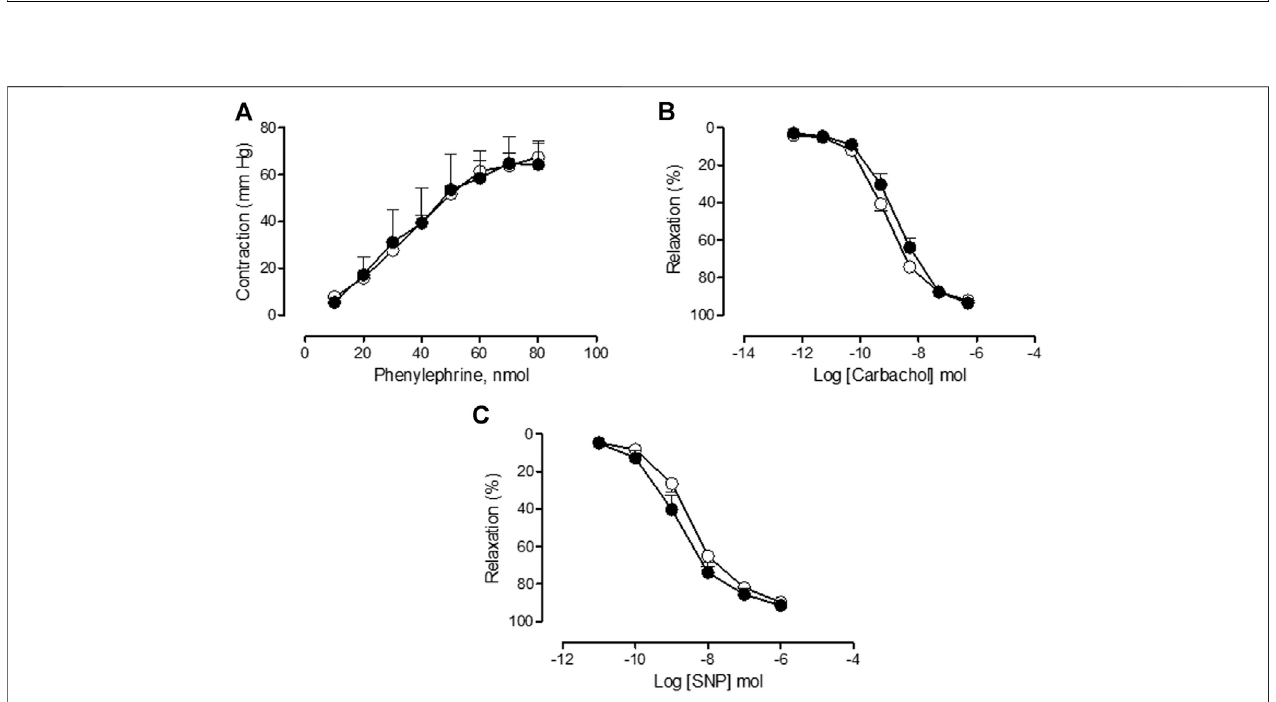
FIGURE 6 | (A) Concentration-response curve of phenylephrine (10 – 80 nmol), (B) concentration-response curve of carbachol (3 · 10 − 10 mol – 3 · 10 − 5 mol), and (C) concentration-response curve of sodium nitroprusside (SNP) (3 · 10 − 11 mol – 3 · 10 − 6 mol) in perfused mesenteric bed from animals two weeks post-treatment with saline (sequelae saline, white circles) or vincristine (sequelae vincristine, black circles). Values are expressed as mean ± SEM, n (cid:2) 6 – 8 preparations per experimental group. A two-way ANOVA followed by the Bonferroni test was used for statistical